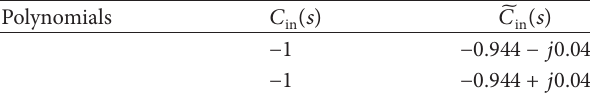
, ̃𝐶 roots comparisons. in in